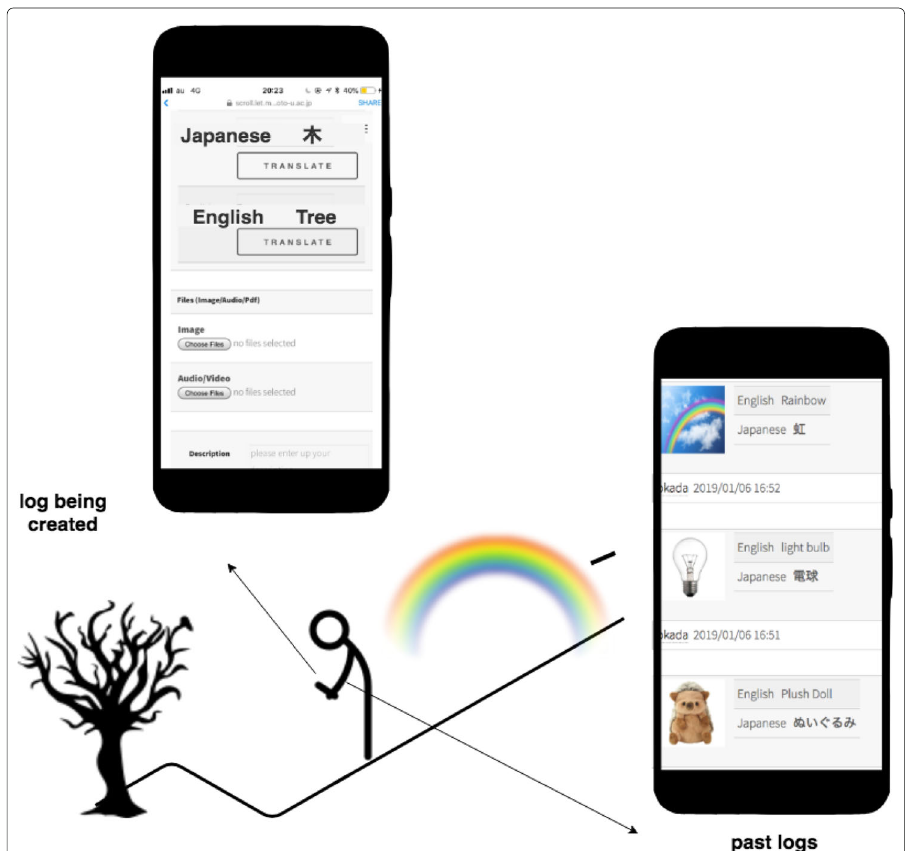
Fig. 2 Log creation and past logs on SCROLL